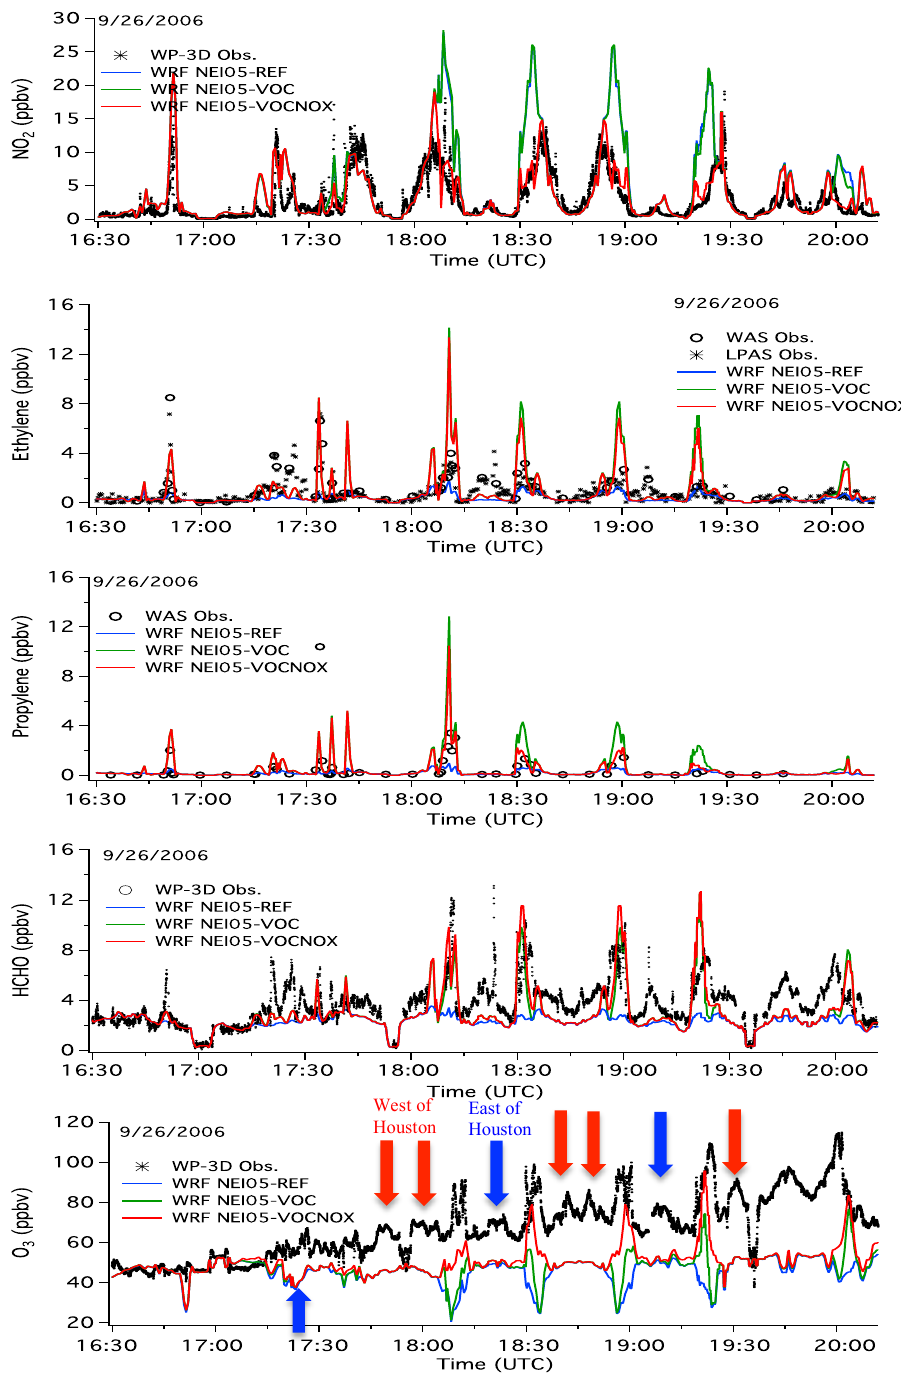
Figure 12. WP-3D observed and simulated NO Fig. 12. WP-3D observed and simulated NO 2 , ethylene, propylene, formaldehyde, and O 3 on 26 September, 2006. The red and the blue arrows denote the west and the east of Houston, 26 September, 2006. Red and blue arrows denote the west and the east of Houston, respectively. 7